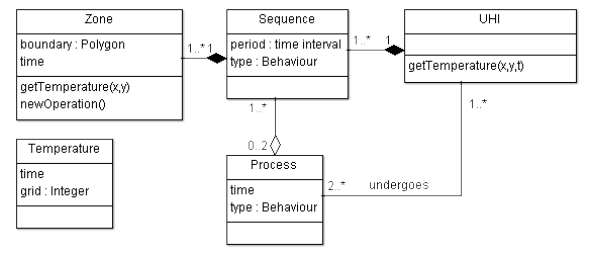
Figure 4: Class diagram of the UHI model.